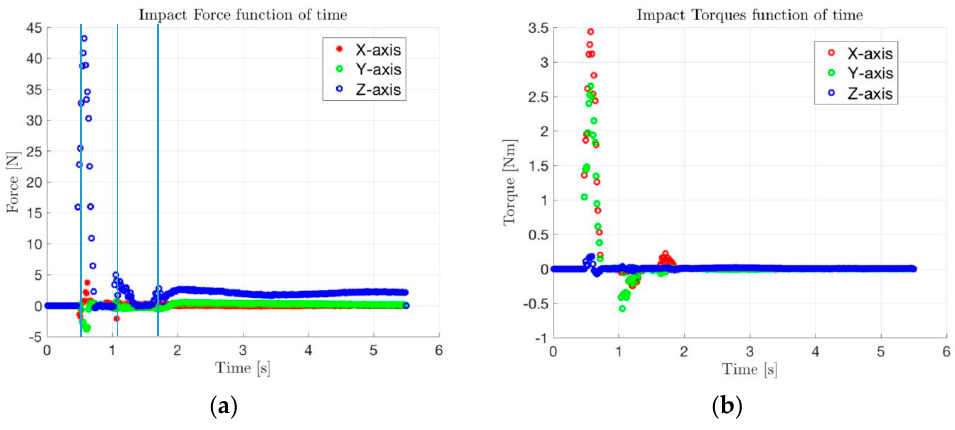
Figure 12. Nominal Case ( v = 0.030 m/s; γ = 3.6 deg): ( a ) forces at impact and ( b ) torques at impact.